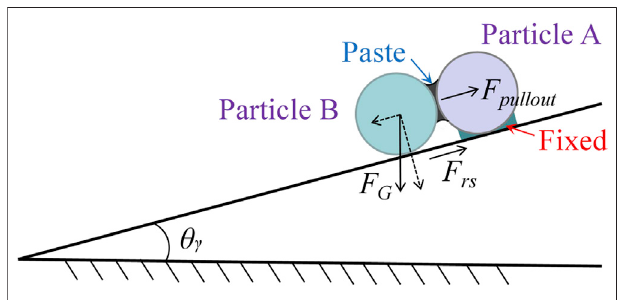
FIGURE 5 | Balance of force in F pullout test.